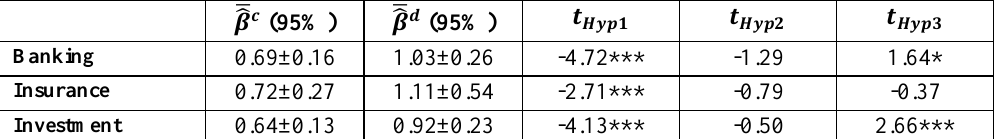
Table 3: Hypothesis testing about betas